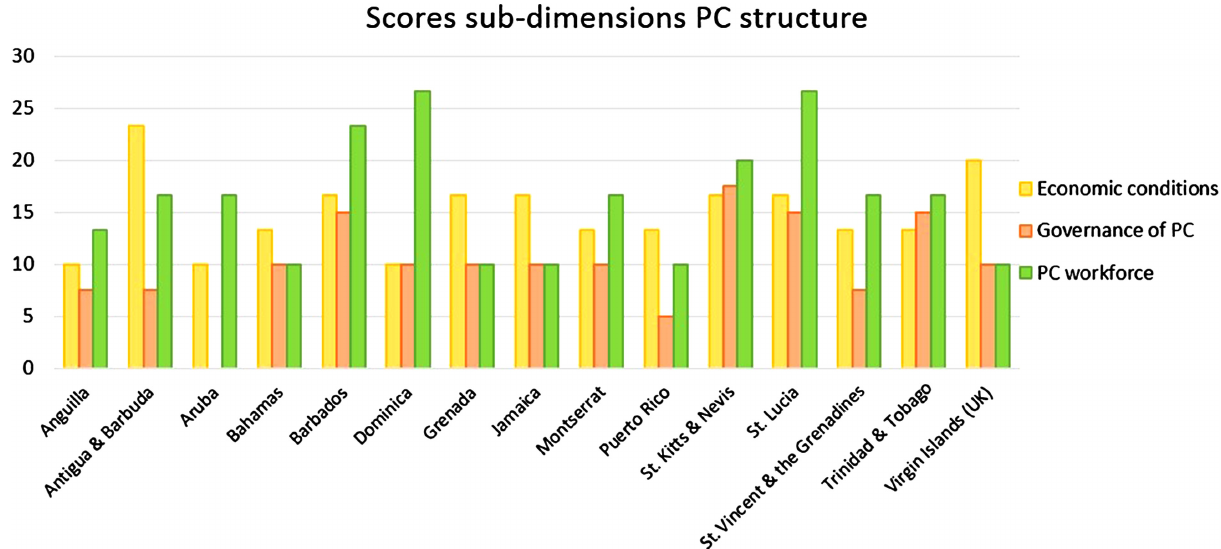
Figure 2 . Scores on sub-dimensions of the structure of